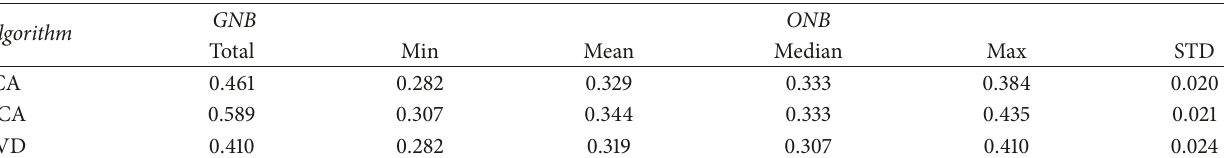
Table 4: Statistics of 51 runs of the optimized and Gaussian Naive-Bayes classifier with 10-fold cross-validation for different data reduction algorithms.